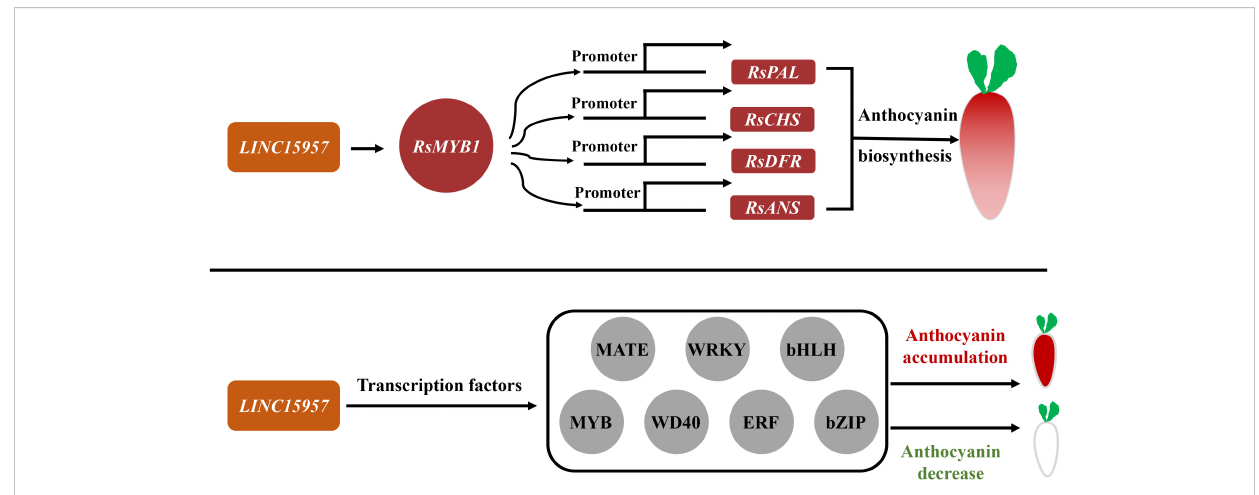
FIGURE 7 The regulatory pattern of LINC15957 with transcription factor and anthocyanin synthesis-related genes. Red represents up-regulation, gray represents up-regulation or down-regulation, rectangle represents genes related to anthocyanin synthesis, and circle represents transcription